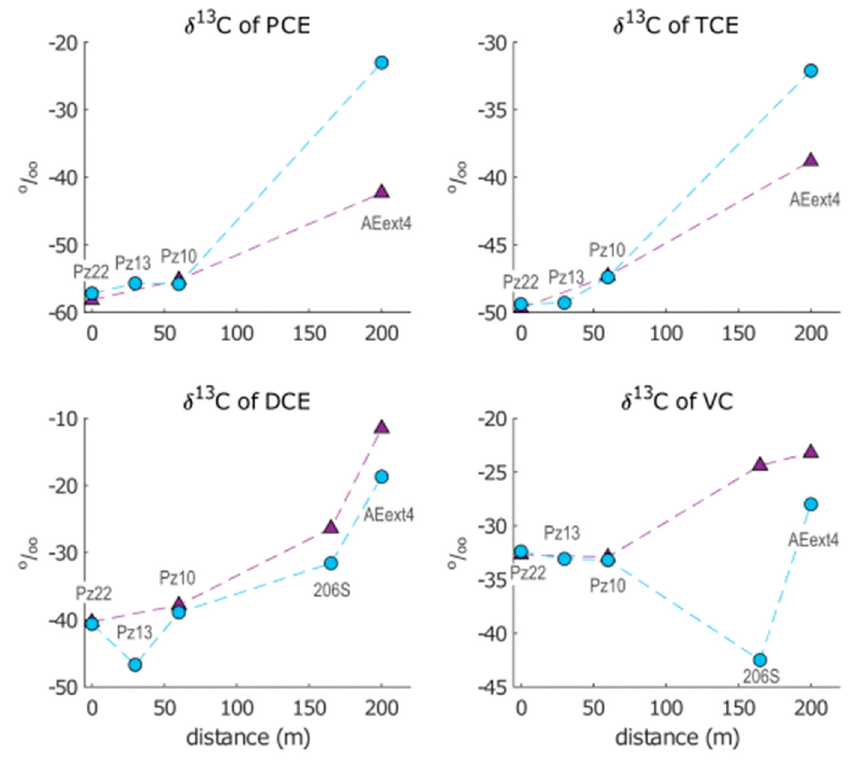
Figure 4. Evolution of isotopic signatures for PCE, TCE, cis-DCE and VC in January 2021 (purple triangles) and May 2021 (blue circles) from Pz22.